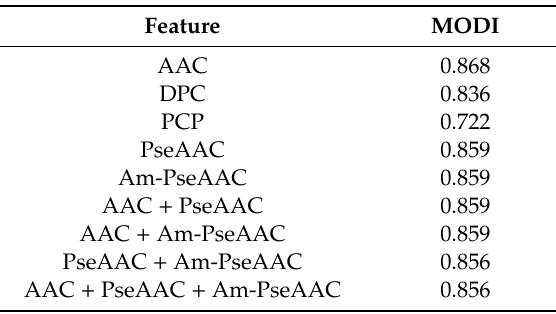
Table A1. Summary of MODI index as derived from various types of peptide features on the benchmark